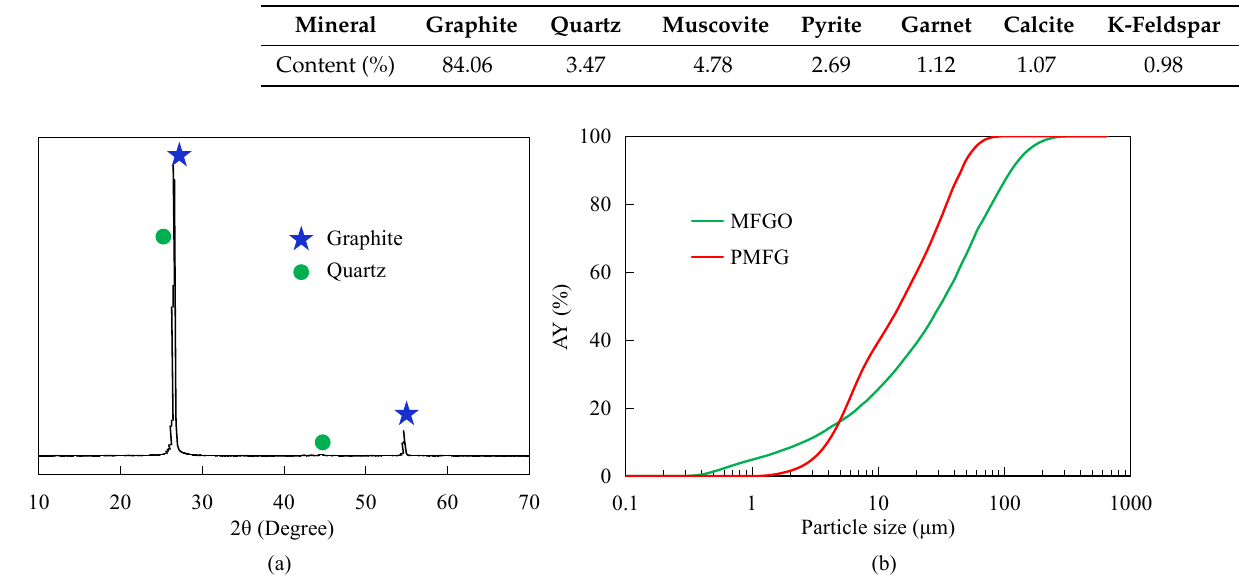
Table 1. Mineral compositions of MFGO.